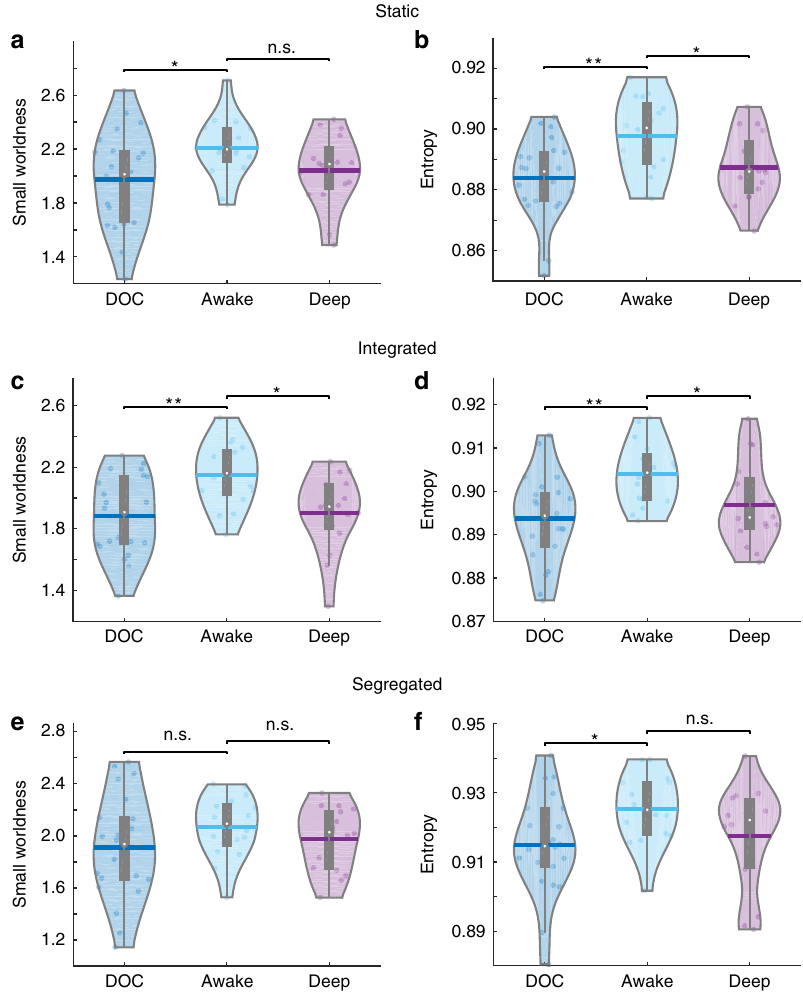
Fig. 3 Violin plots of the mean connectivity entropy (left) and small-world values (right) for the static ( a , b ), integrated ( c , d ) and segregated ( e , f ) states, comparing conscious healthy controls and unconscious individuals due to anaesthesia (repeated_measures t -tests) and brain injury (two-samples t -tests). The small-world index was calculated as the ratio of normalised clustering coef fi cient to normalised characteristic path length. n.s. not signi fi cant; * p < 0.05; ** p < 0.01; white circle, mean; centre line, median; box limits, upper and lower quartiles; whiskers, 1.5× interquartile range. Source data are provided as a Source Data fi